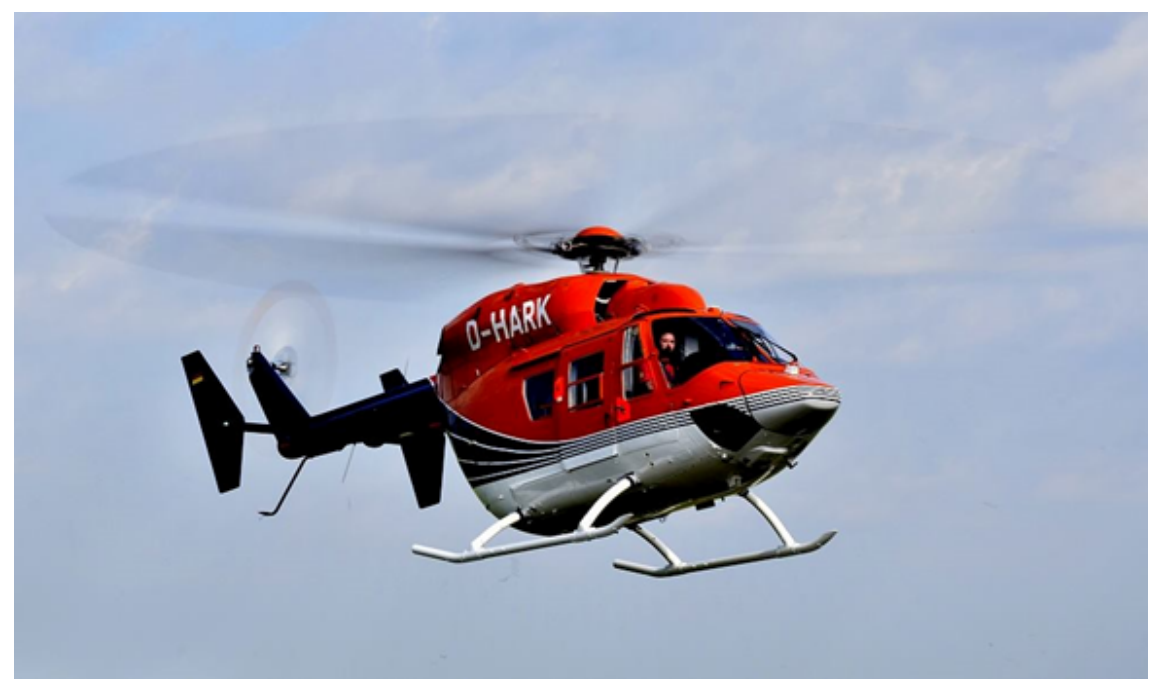
Figure 2: Polarstern Helicopter BK 117 - C1. Photo: AWI / M. Steffens.